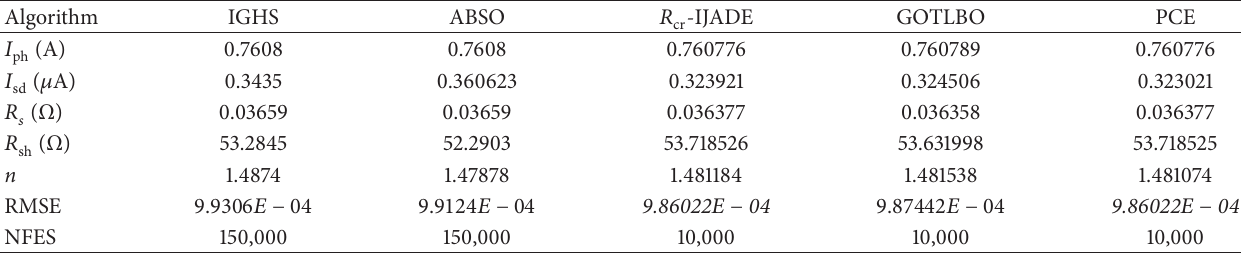
Table 11: Data comparison of the single diode model from the related literature.